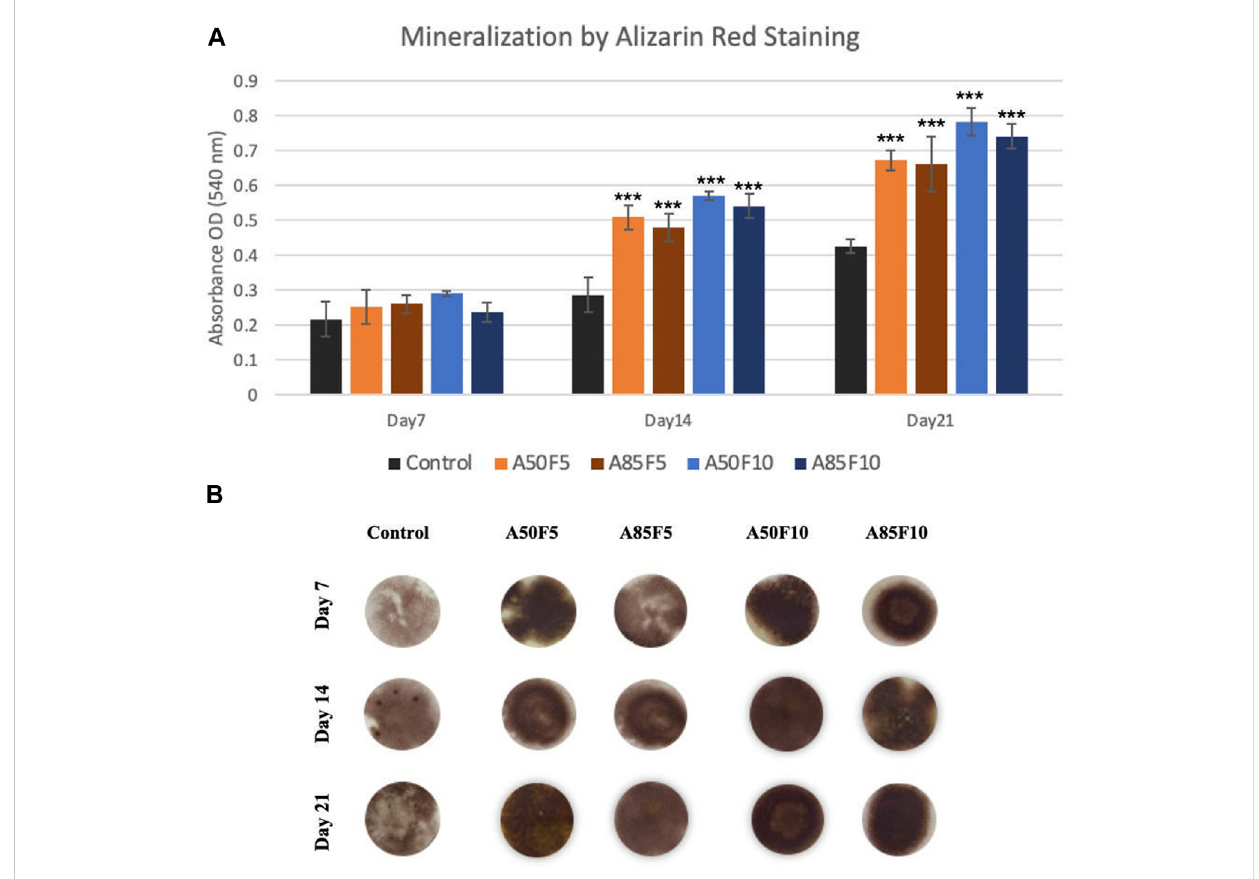
FIGURE 13 (A) Enhancedmineralization capability (late-stage markers) ofosteoblasts on fi bronectin grafted diskscan be seen (Signi fi cant difference compared with control is indicated with *, p < 0.05, **, p < 0.005, and ***, p < 0.001, (B) Alizarin red S-stained images of sample groups from Day 7 to Day